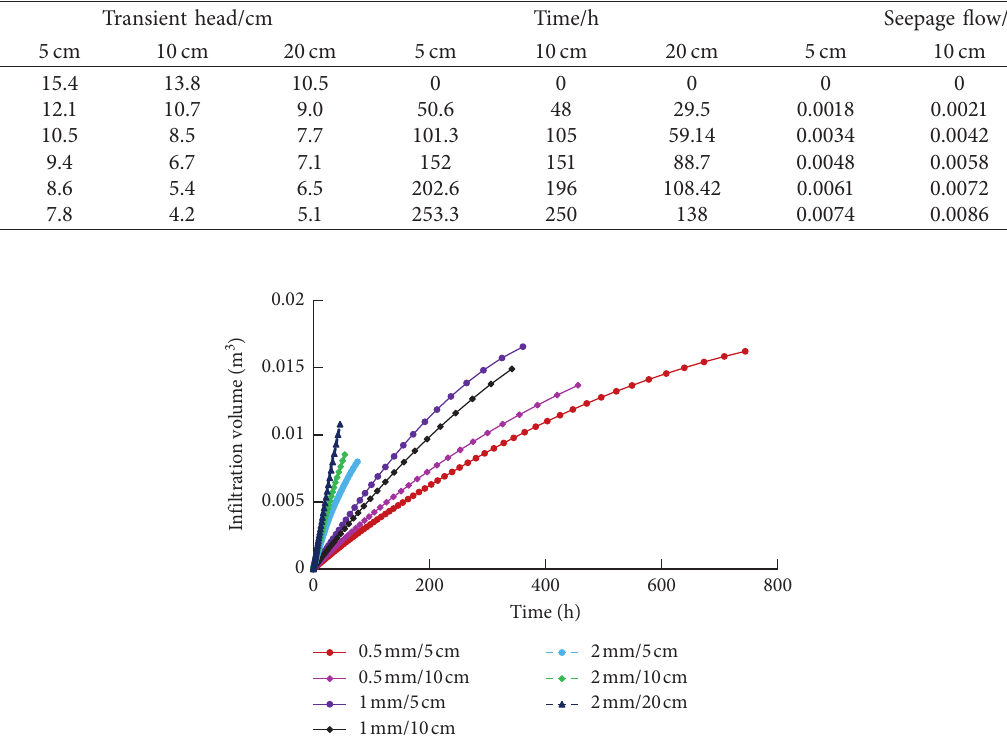
Figure 13: Numerical simulation cumulative infiltration volume and time relationship curve.